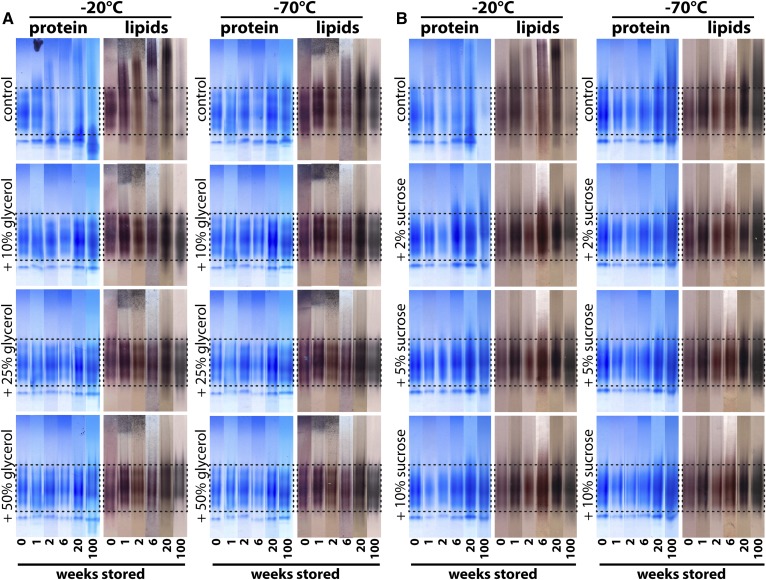
Native gel electrophoresis of cryopreserved HDL. HDL isolated by density gradient ultracentrifugation was stored at −20°C or −70°C in the presence or absence of the cryoprotectants glycerol (10–50%) (A) or sucrose (2–10%) (B) for up to 100 weeks. Aliquots were analyzed at different time points and stained with Coomassie brilliant blue for protein or with Sudan black B for lipids. The dashed lines indicate the typical size range of HDL2 and HDL3 ranging from about 8 to 12 nm. To be able to illustrate structural changes of HDL upon long-term storage, we have placed the analyzed time points from each sample next to each other. Samples represent pooled HDL preparation from four healthy donors. Each storage experiment was repeated three times and results from one representative experiment are shown.